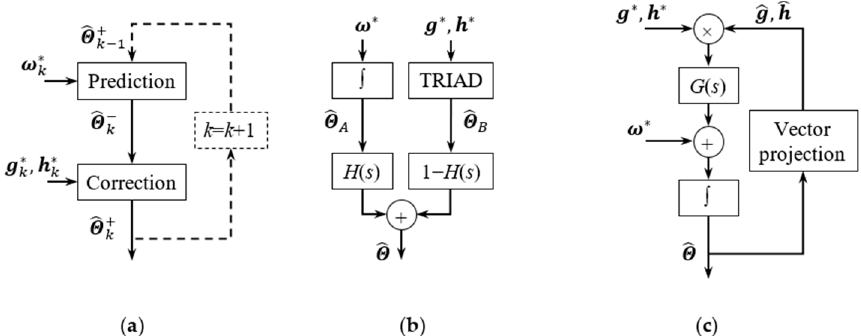
Figure 1. Block diagram of Kalman filter and complementary filter for 3D attitude estimation. ( a )